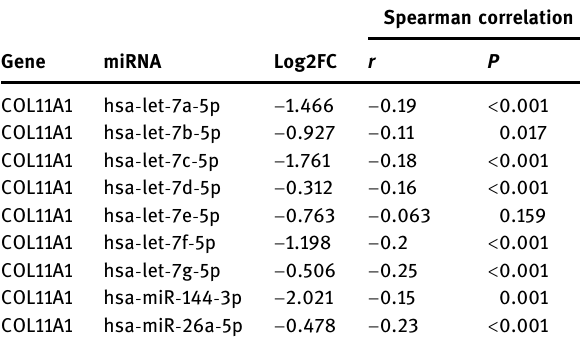
Table 2: COL11A1 - related